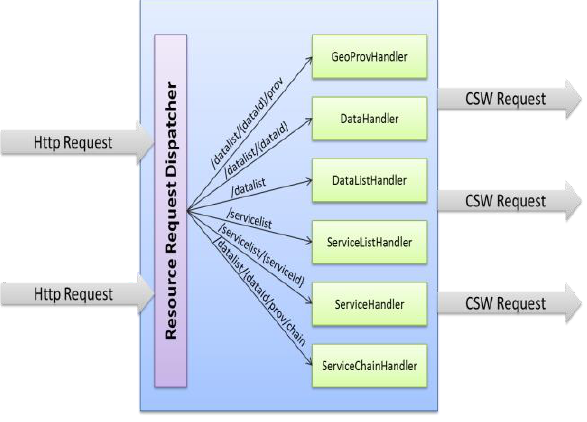
Figure 3. Mechanism of the REST